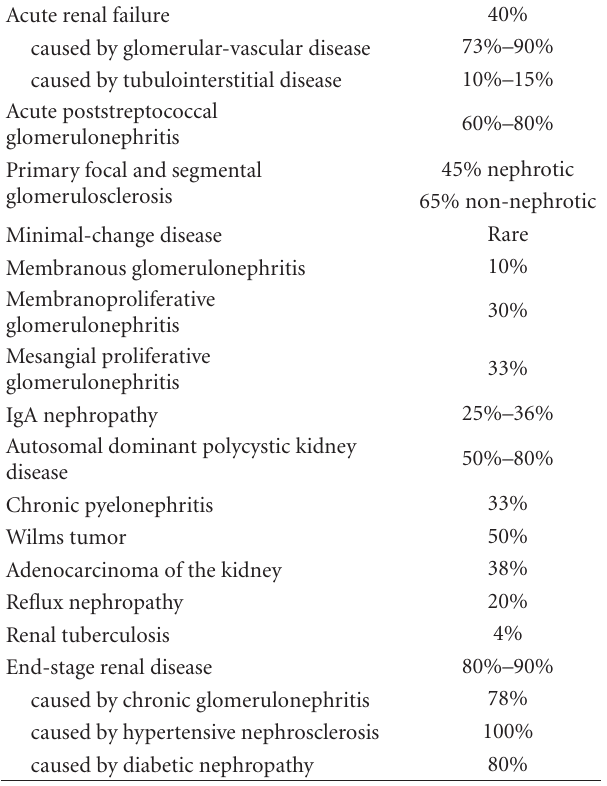
Table 2: Prevalence of hypertension secondary to underlying renal parenchymal